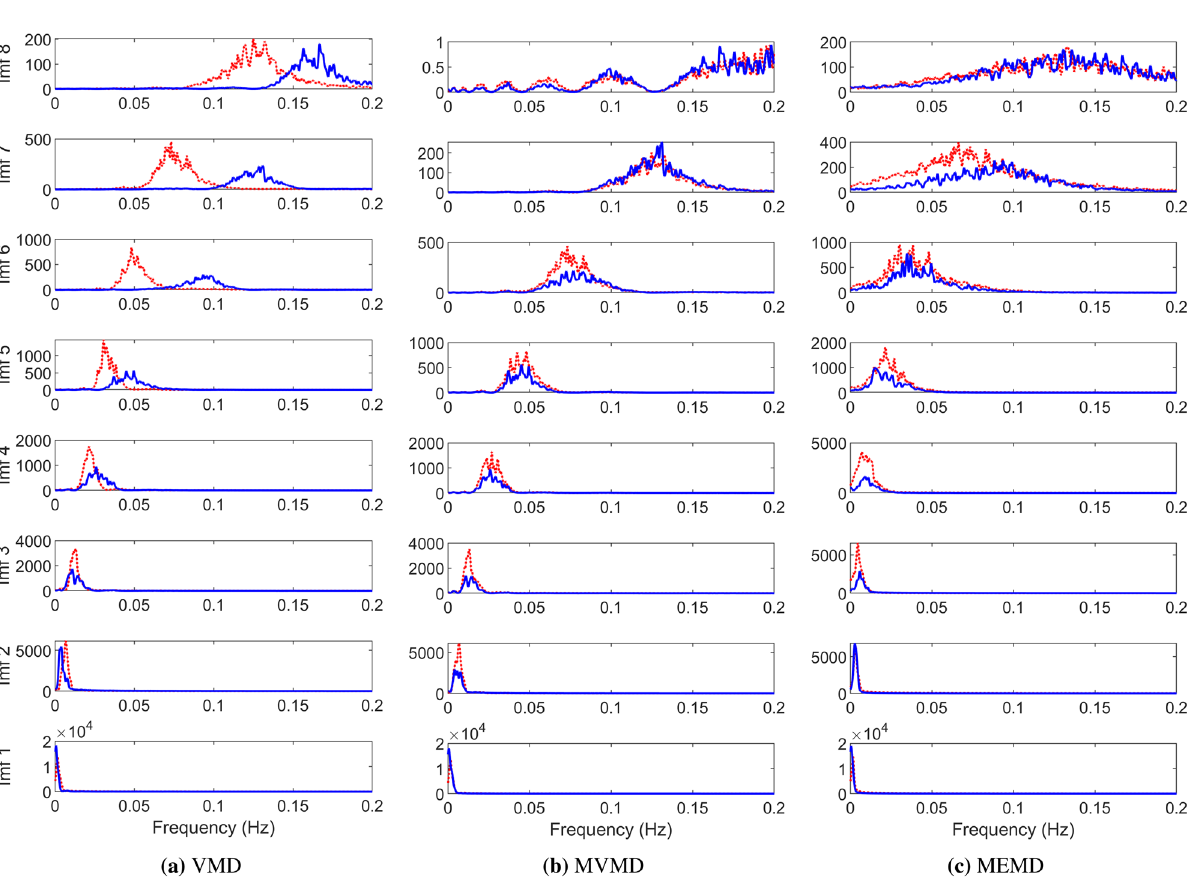
Figure 8. Demonstration of mode-alignment capability of multivariate SD approaches on real-life biomedical data. The mode-alignment is not present in the case of VMD ( a ) whereas the decomposition obtained via MVMD ( b ) and BEMD ( c ) shows proper mode-alignment, with MVMD showing better mode-separation than